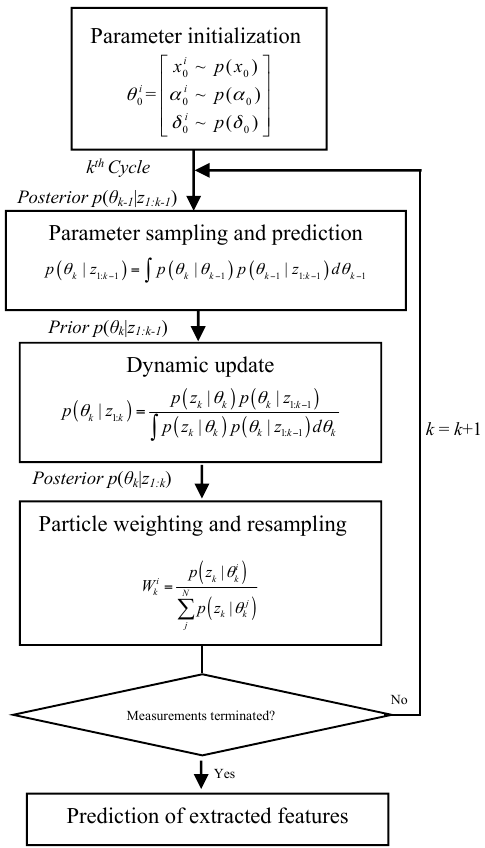
Figure 5. Particle filter (PF) prediction approach.